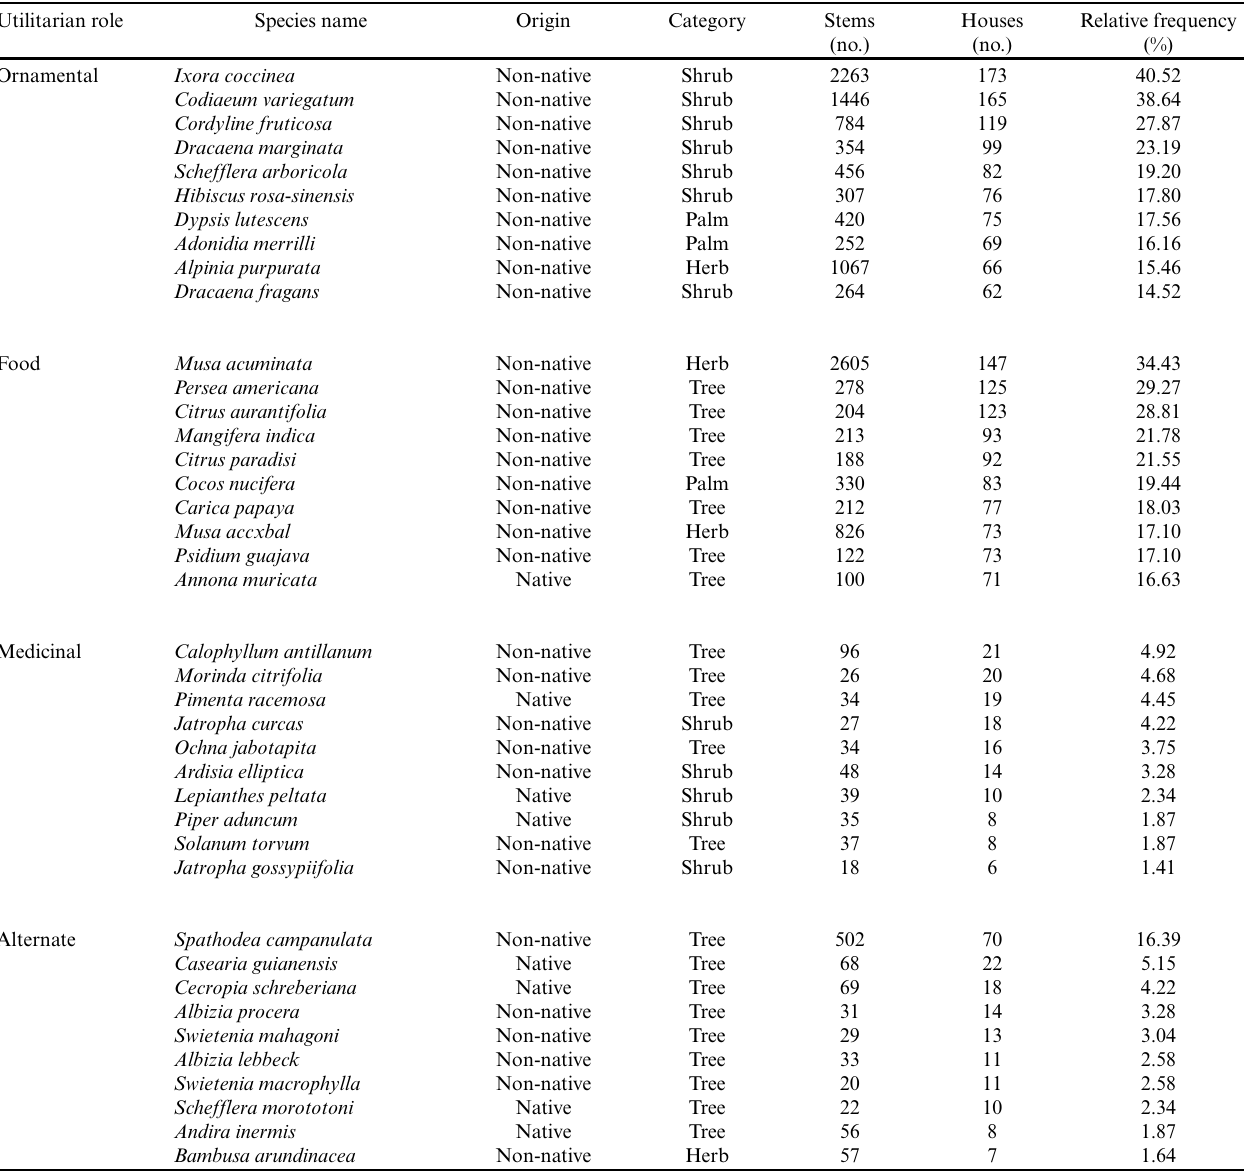
Table 2 . Relative frequency of the ten most abundant species for each utilitarian role in Río Piedras watershed. Relative frequency values were calculated based on the total number of houses visited (n =